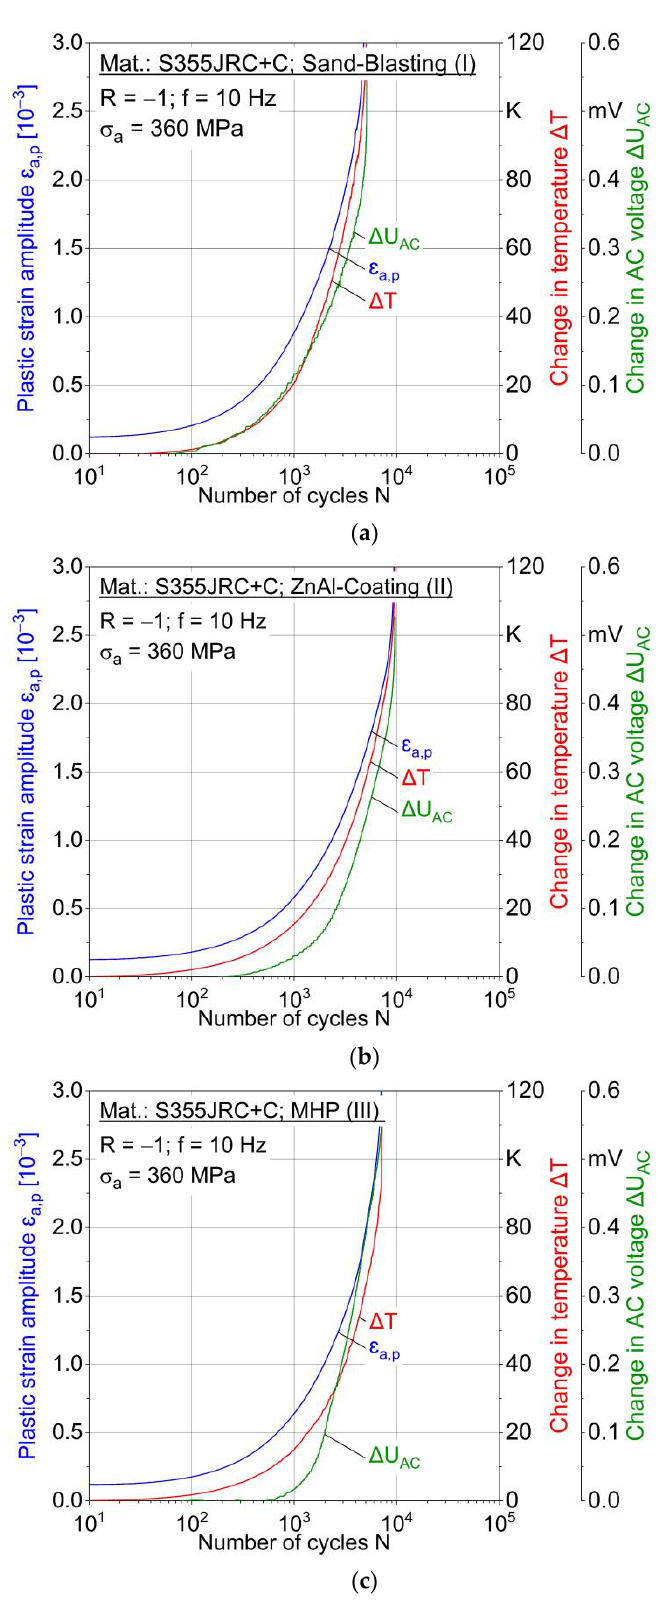
Figure 15. Constant amplitude tests (CAT) at 360 MPa for ( a ) sandblasted (I), ( b ) ZnAl-coated (II) and ( c ) machine hammer-peened (III) specimens.